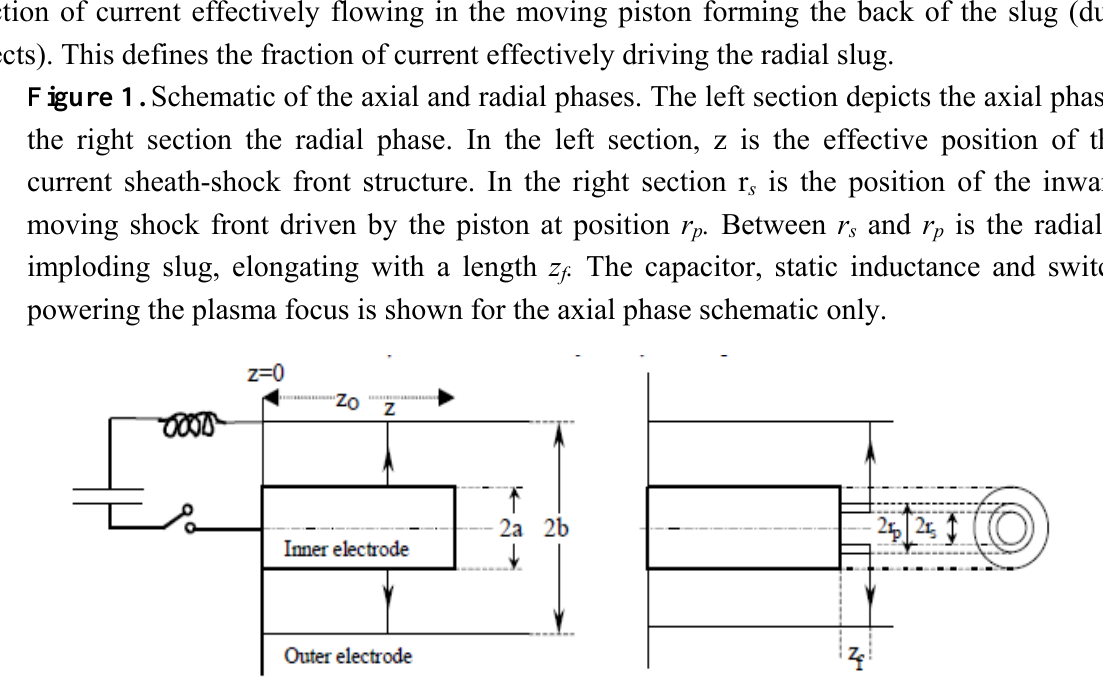
Figure 2. Schematic of radius versus time trajectories to illustrate the radial inward shock phase when r moves radially inwards, the reflected shock (RS) phase when the reflected s shock moves radially outwards, until it hits the incoming piston r pinch phase ( t ) and finally the expanded column f